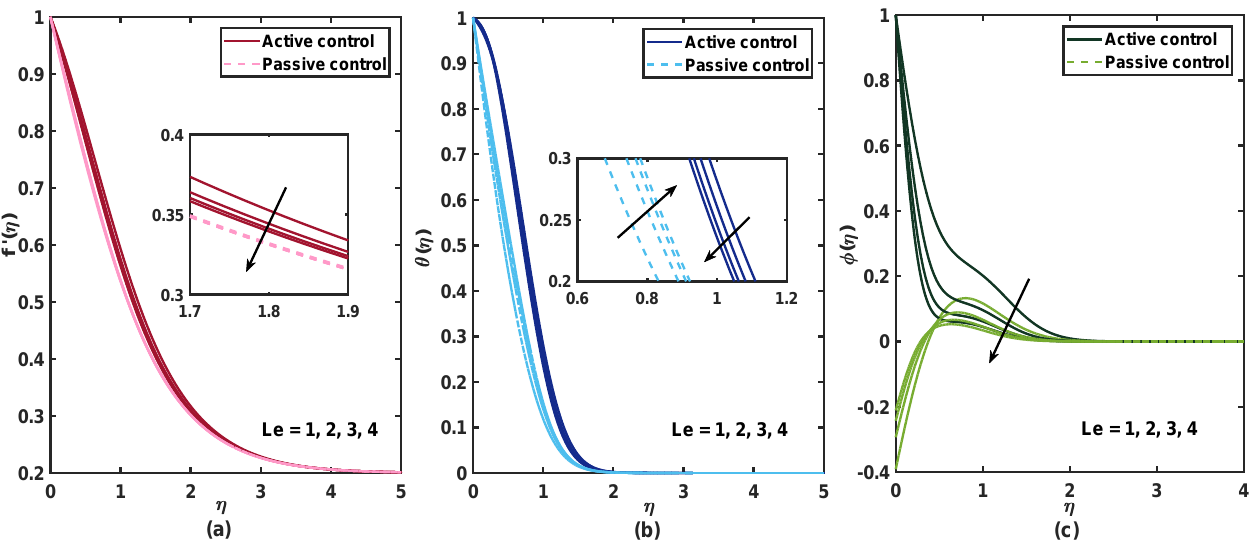
Figure 9. Impact of Lewis number Le on ( a ) velocity, ( b ) temperature, and ( c ) nanoparticle volume fraction